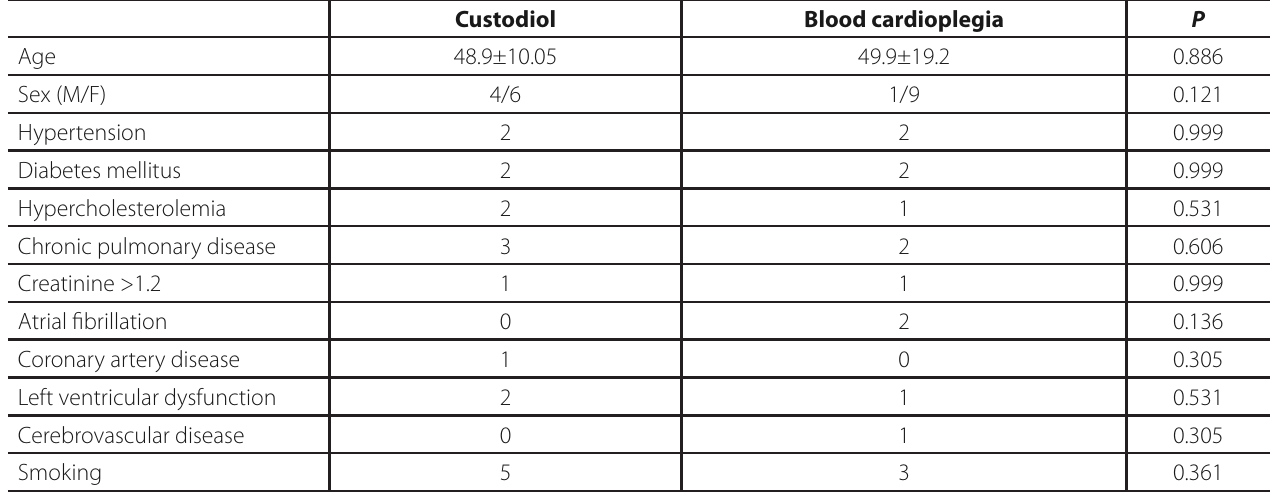
Table 2. Demographic data and risk factors.